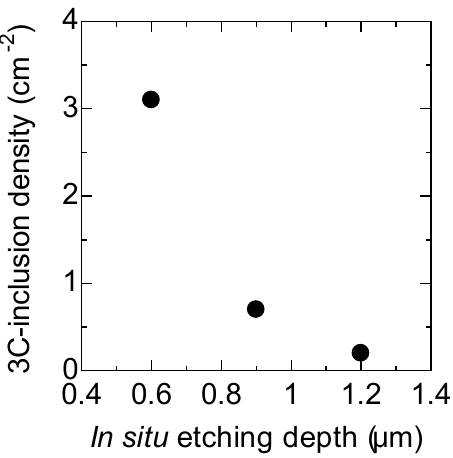
Figure 4. Relationship between 3 C -inclusion density and in situ etching depth for a C/Si ratio of